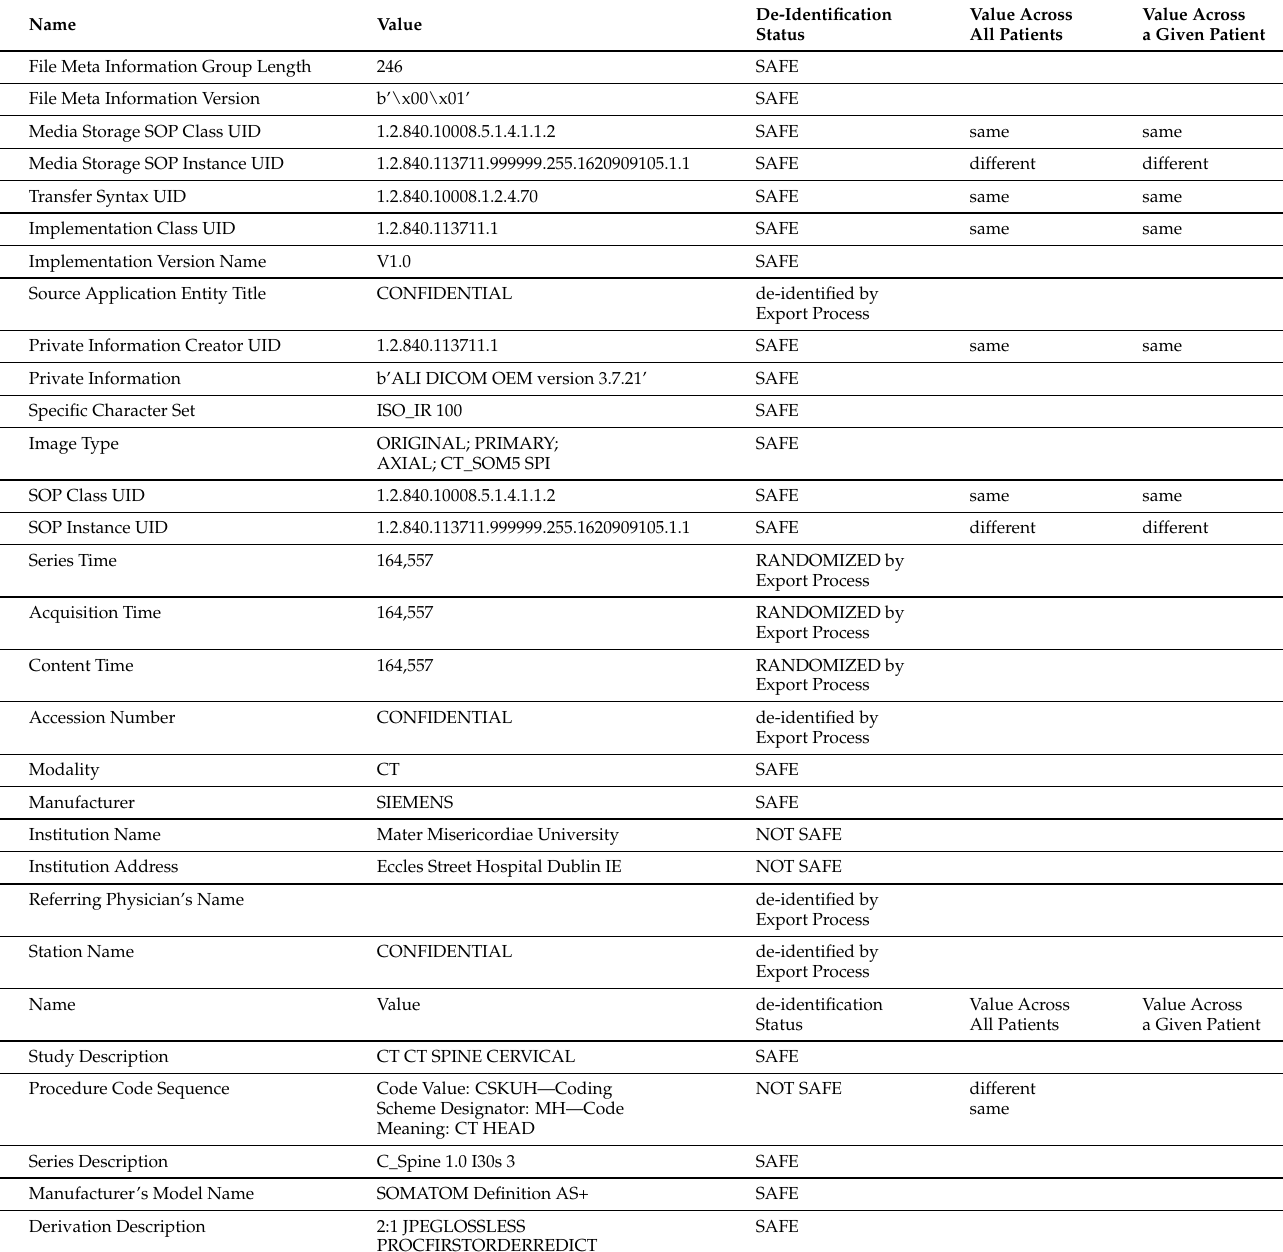
Table A1. Detailed examination of DICOM headers (part